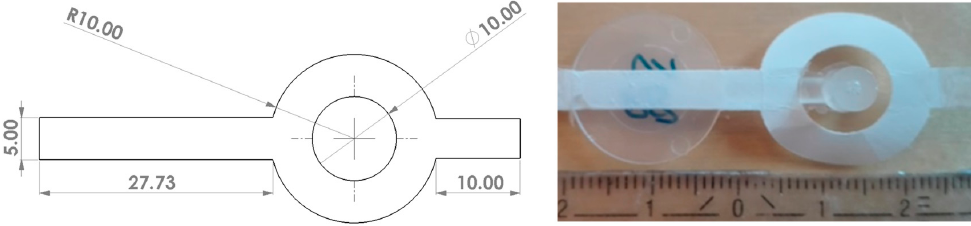
Figure 2. Design of the film insert blank ( left , all dimensions in mm), film insert moulding (FIM)-part including sprue, runner, gate and untrimmed film insert ( right ).